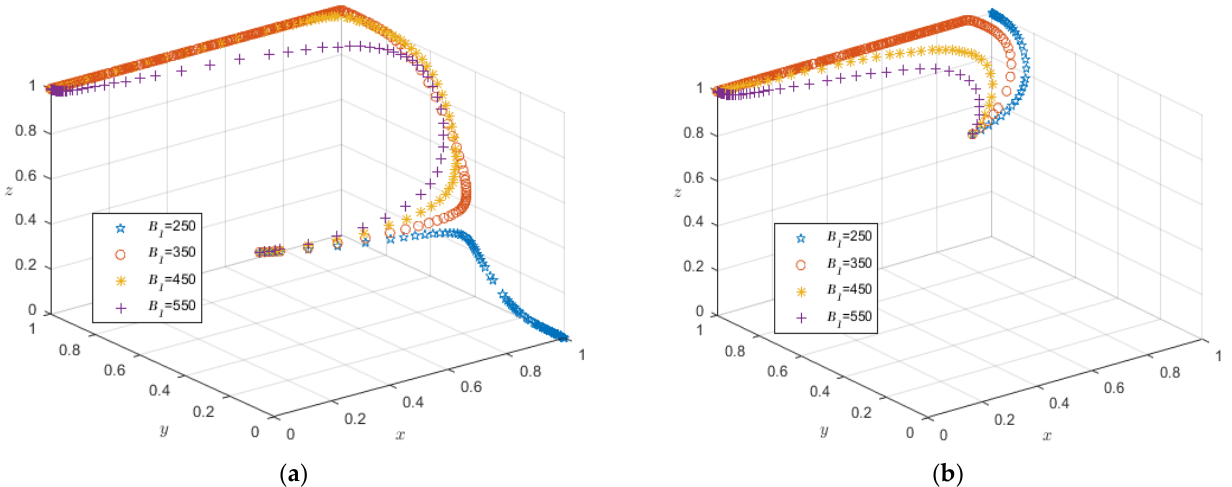
Figure 4. The evolution path of the different farmers’ subsidies: ( a ) evolution path of System A with (x 0 , y 0 , z 0 ) = (0.32, 0.48, 0.4); ( b ) evolution path of System B with (x 1 , y 1 , z 1 ) = (0.7, 0.7, 0.7).